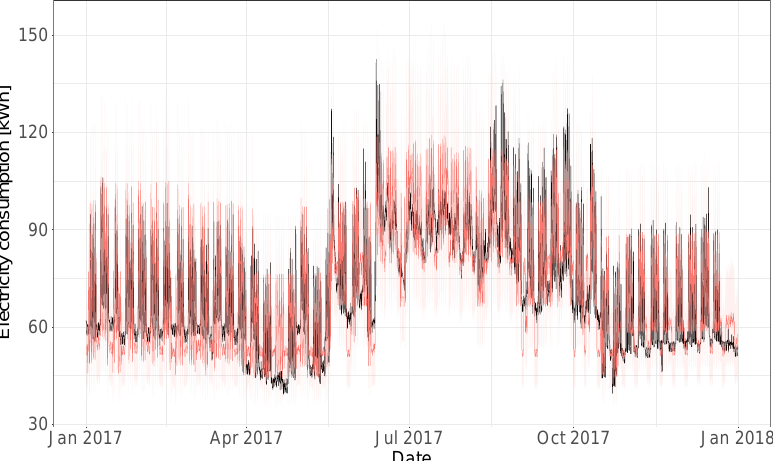
Figure 18. Test year metered electricity time-series (in black) and model predictions (in red) for Rat_education_Royal